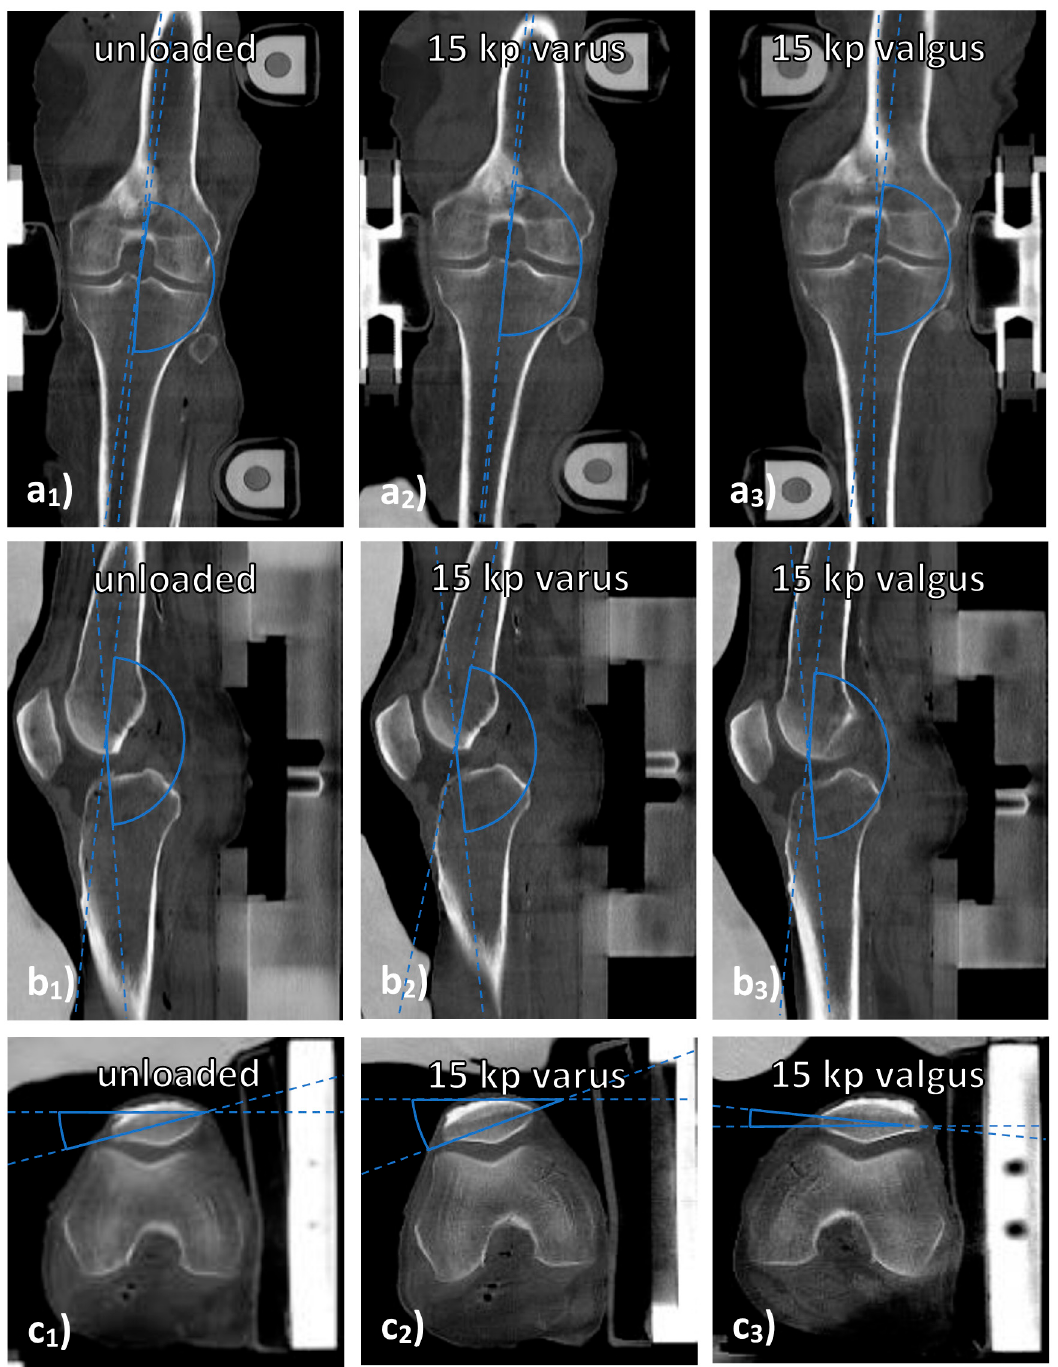
Figure 1. Measurements of joint alignment on CT images. Visualized are coronal ( a ), sagittal ( b ), and axial ( c ) reconstructions of a representative knee joint under various loading conditions, i.e., unloaded ( a 1 –c 1 ), under 15 kp varus loading ( a 2 –c 2 ) and under 15 kp valgus loading ( a 3 –a 3 ). “Joint deviation” was determined on mid-coronal images as the lateral angle between the femoral and tibial shafts ( a ). “Joint extension” was determined on mid-sagittal images as the popliteal angle between the femoral and tibial shafts ( b ). “Joint rotation” was determined on the axial images that demonstrated the largest diameter of the patella by relating the trans-patellar line (through the outer corners of the patella) to the horizontal line ( c ). By convention, external rotation was indicated by positive angles and internal rotation by negative